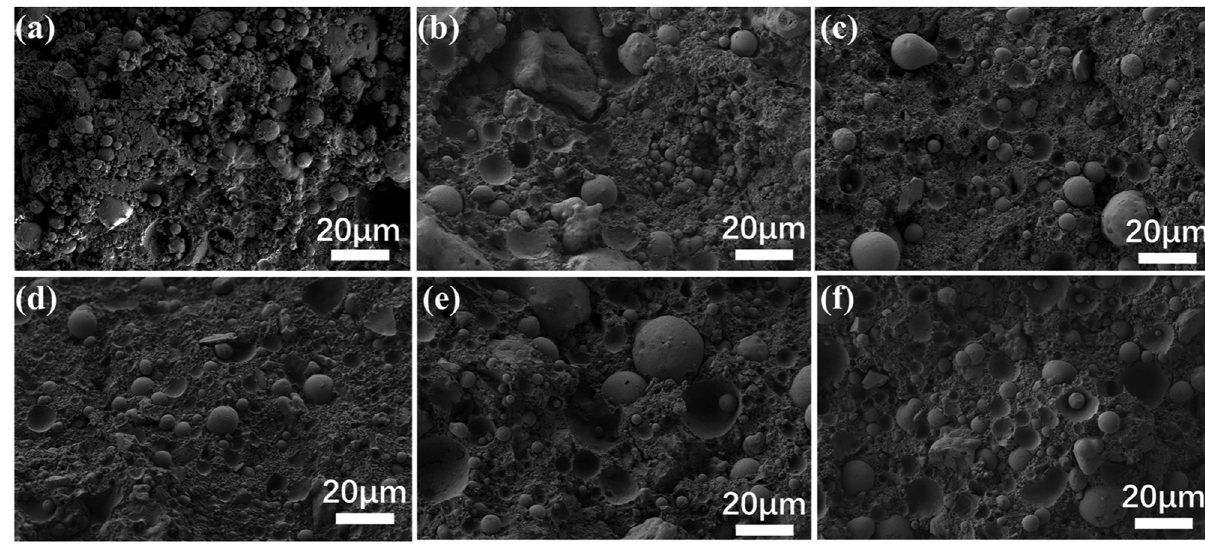
Figure 6: SEM images of ( a ) unmodi fi ed r - PVC/CFA composites, ( b ) modi fi ed r - PVC/CFA - P ( 80 phr CFA ) , and ( c ) – ( f ) r - PVC/CFA - X composites varied with X ( 40, 60, 80, and 100 )